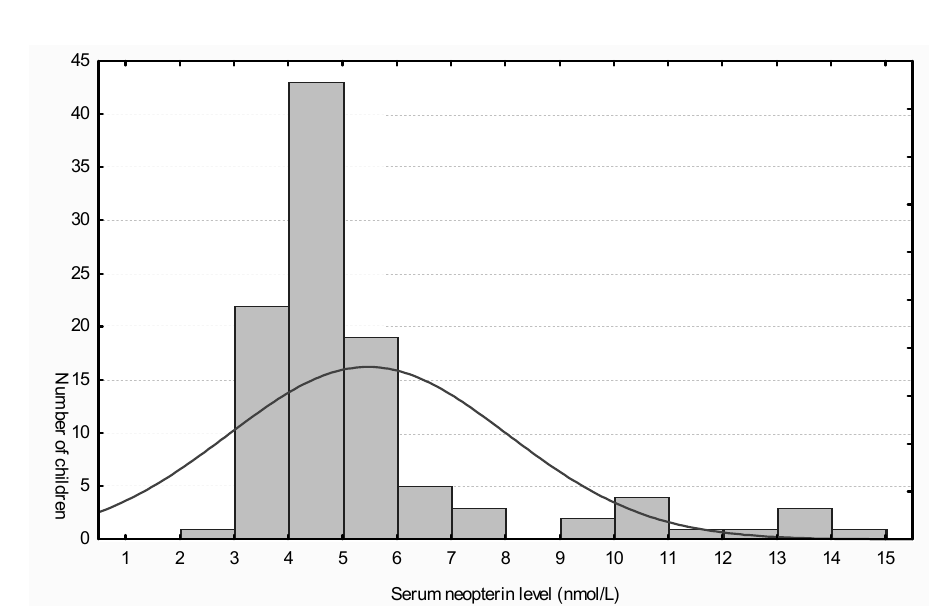
Figure 1. Distribution of serum neopterin concentrations in studied group of children